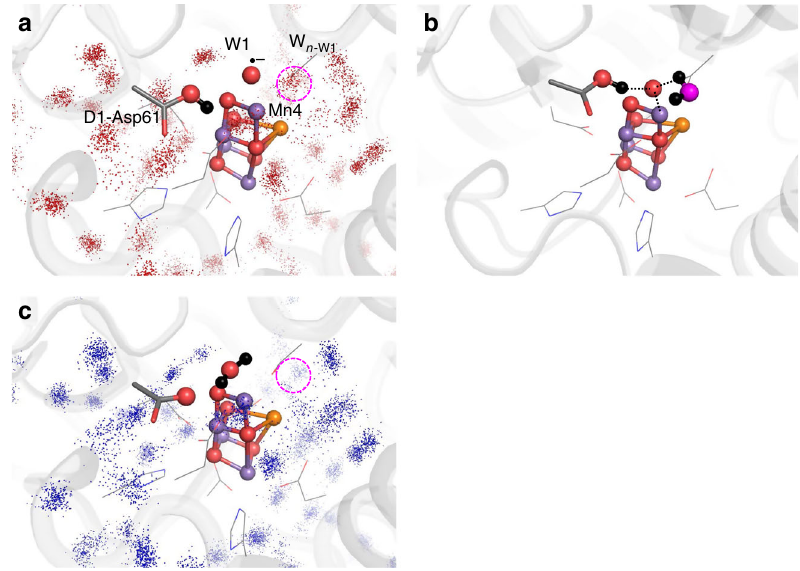
Fig. 3 Water distribution near the Mn 4 CaO 5 cluster. a Water distribution in S 3 after an equilibrating MD run at 45 − 50 ns (250 snapshots). The position of W n -W1 is indicated by the dotted circle. b The corresponding view in the QM/MM-optimized geometry in S 3 . Dotted black lines indicate interactions. c Water distribution in S 1 after an equilibrating MD run at 45 − 50 ns (250 snapshots). W n -W1 is absent in S 1 (dotted